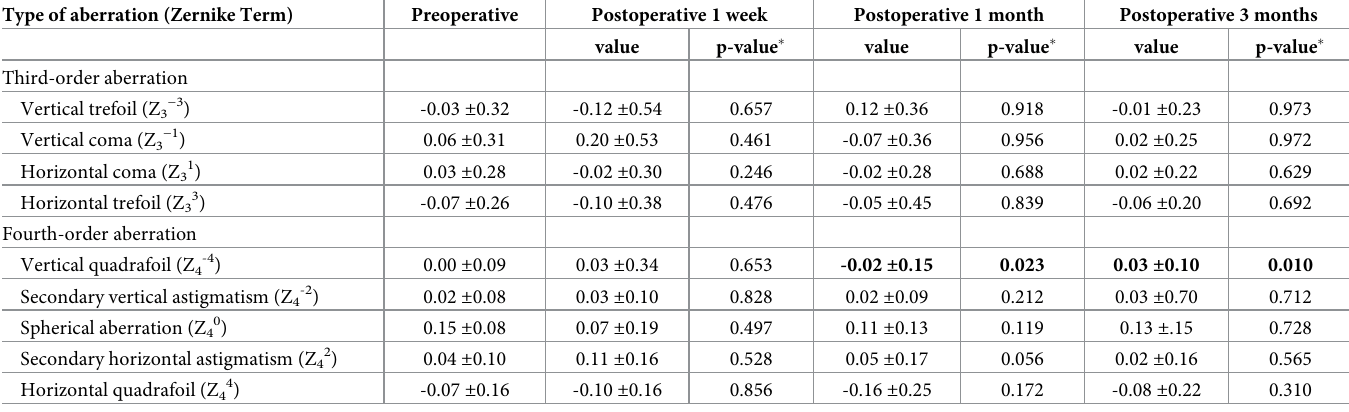
Table 6. Preoperative and postoperative 1 week, 1 and 3 months corneal HOAs with 6 mm diameter central corneal zone in group B (mean ± SD,